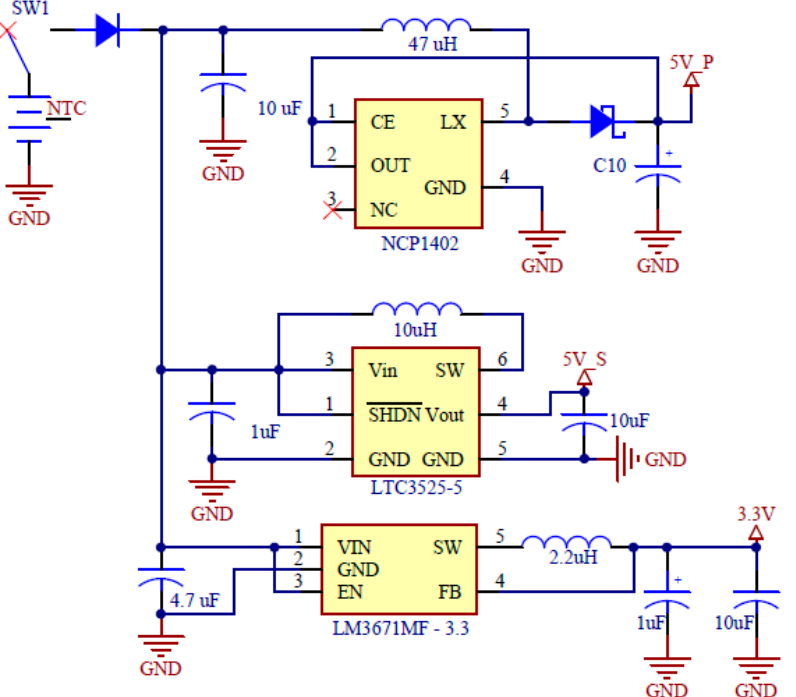
Figure 4. Electrical diagram of voltage conversion corresponding to PV4.